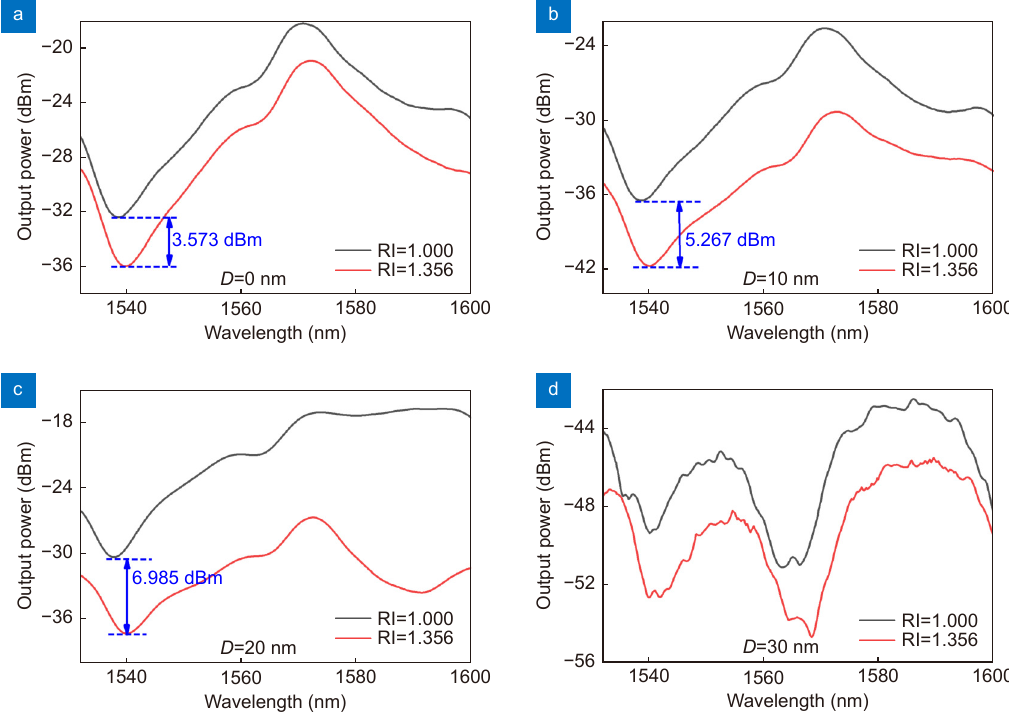
Fig. 8 | Transmission spectra of different SP-depths. ( a ) D =0 μm. ( b ) D =10 μm. ( c ) D =20 μm. ( d ) D =30